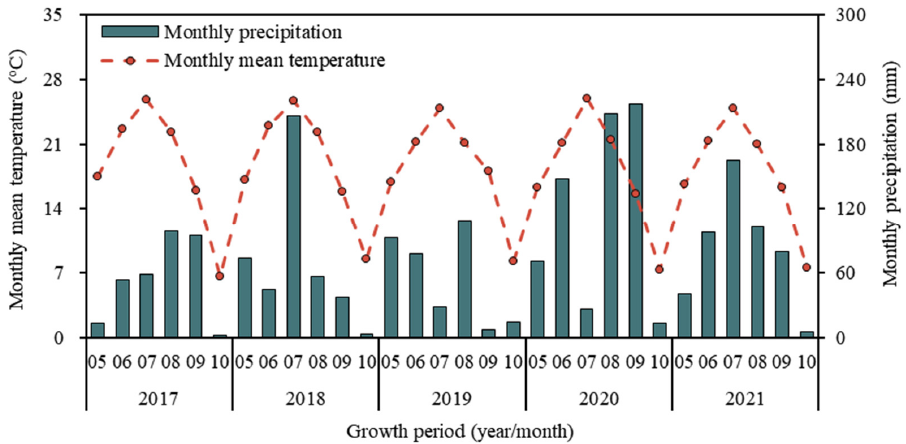
Figure 1. Monthly mean air temperature and precipitation during the maize growth period in 2017–2021. Table 1. Initial soil properties at a 0–40 cm depth at 20 cm intervals before the experiment.